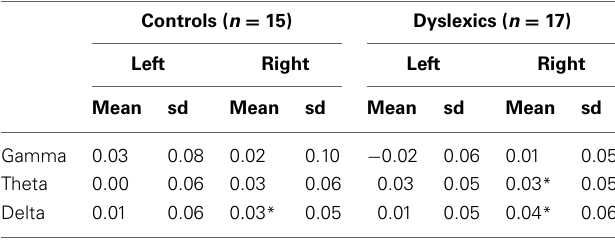
Table 2 | Mean values of partial